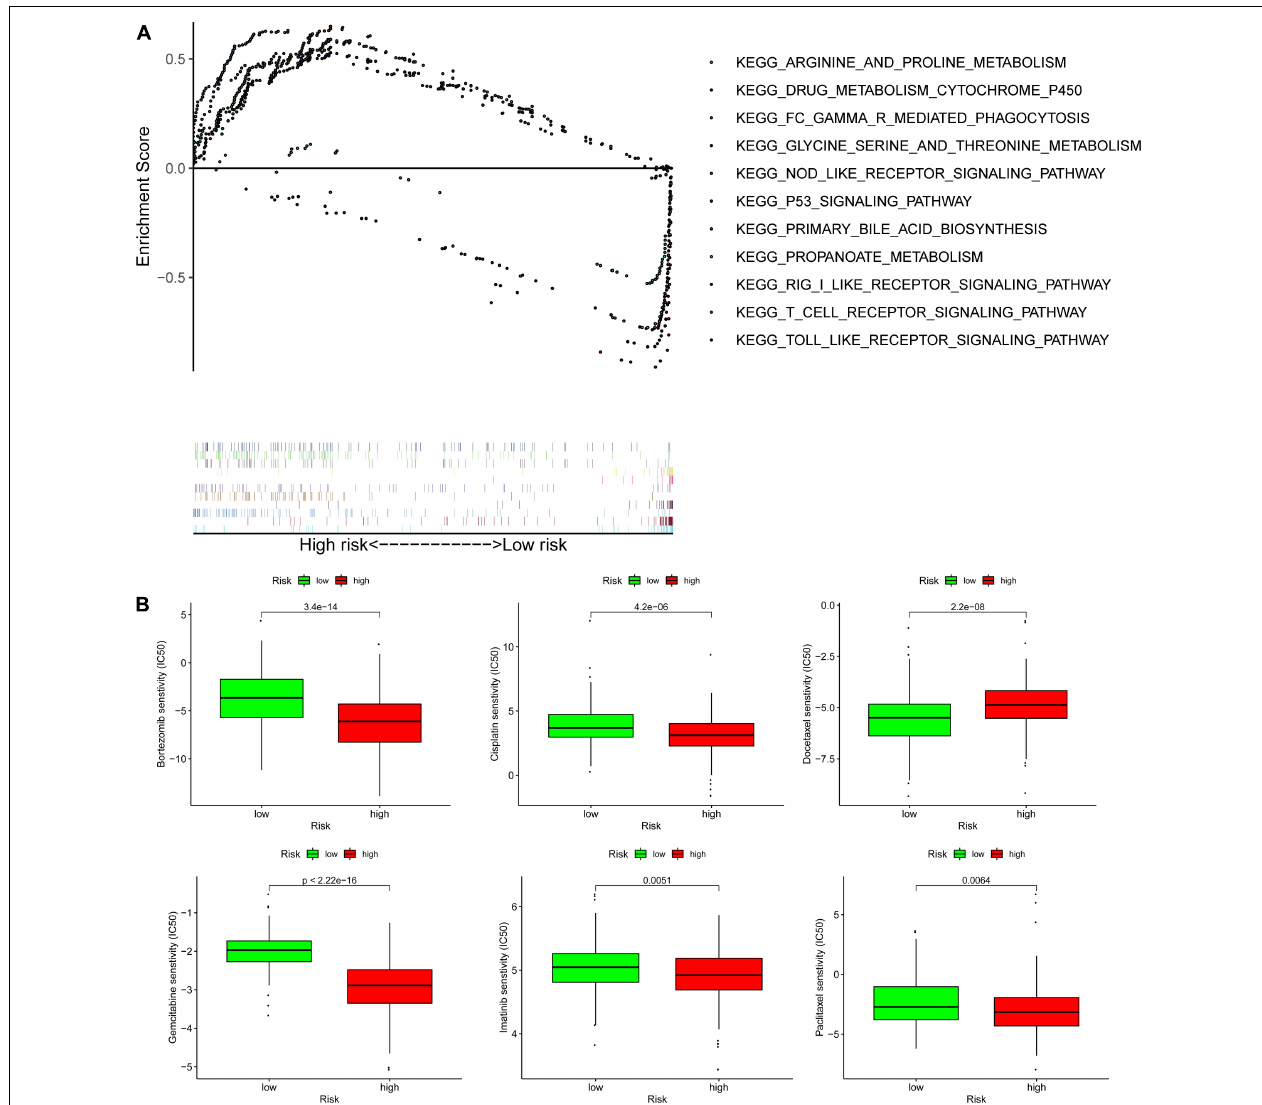
FIGURE 8 | Gene set enrichment analysis (GSEA) and lower half inhibitory centration (IC50) of chemotherapeutic drugs between the high- and low-risk group based on the pyroptosis-related lncRNA signature in TCGA-HCC. (A) GSEA results suggested that the two risk groups were mainly enriched in the tumor-, immune-, and metabolism-related pathways. (B) A low-risk score was related to an IC50 of chemotherapeutics such as bortezomib, and a high-risk score was related to docetaxel.